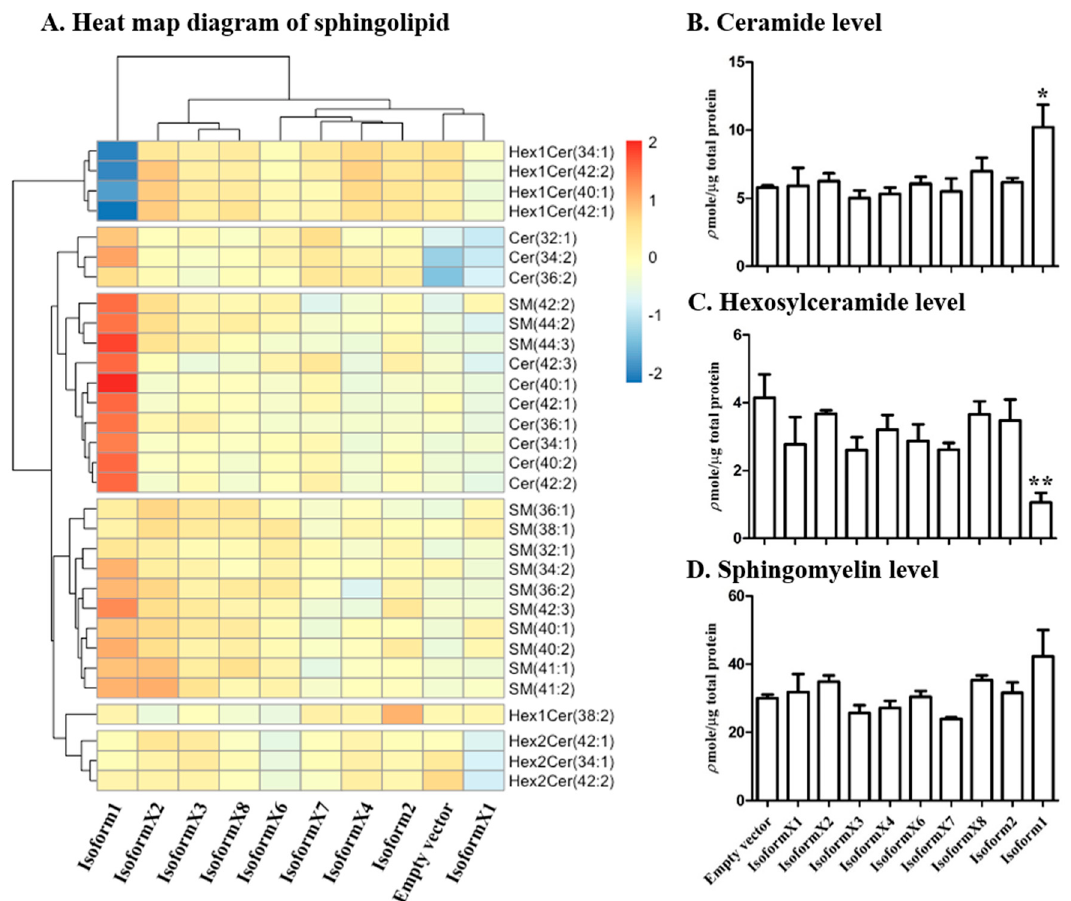
Figure 4. Relative sphingolipid levels in cells expressing respective human GBA2 isoforms. ( A ) The heat map illustrates Z-score di ff erences from mean of sphingolipid in cells expressing the human GBA2 isoforms and control at 48 h after transfection, while the cluster maps illustrate the similarities of the patterns. The z-scores are color-coded from blue (lower than average for that lipid species) to red (higher than average for that lipid species), ( B ) ceramide (34:1, 36:1, 40:1, 40:2, 42:1, 42:2, and 42:3), ( C ) hexosylceramide (34:1, 40:1, 42:1, and 42:2), and ( D ) sphingomyelin (36:2, 40:1, 40:2, 41:1, 41:2, 42:1, 42:2, 42:3, 44:2, and 44:3) expressed as bar graphs. Values are means of three independent biological replicates with standard deviations shown as error bars, * p < 0.05 and ** p < 0.01 for di ff erences compared to empty vector control in a two-tailed unpaired t-test. Shapiro-Wilk analysis showed no significant deviation from a normal distribution for those conditions showing significant differences .